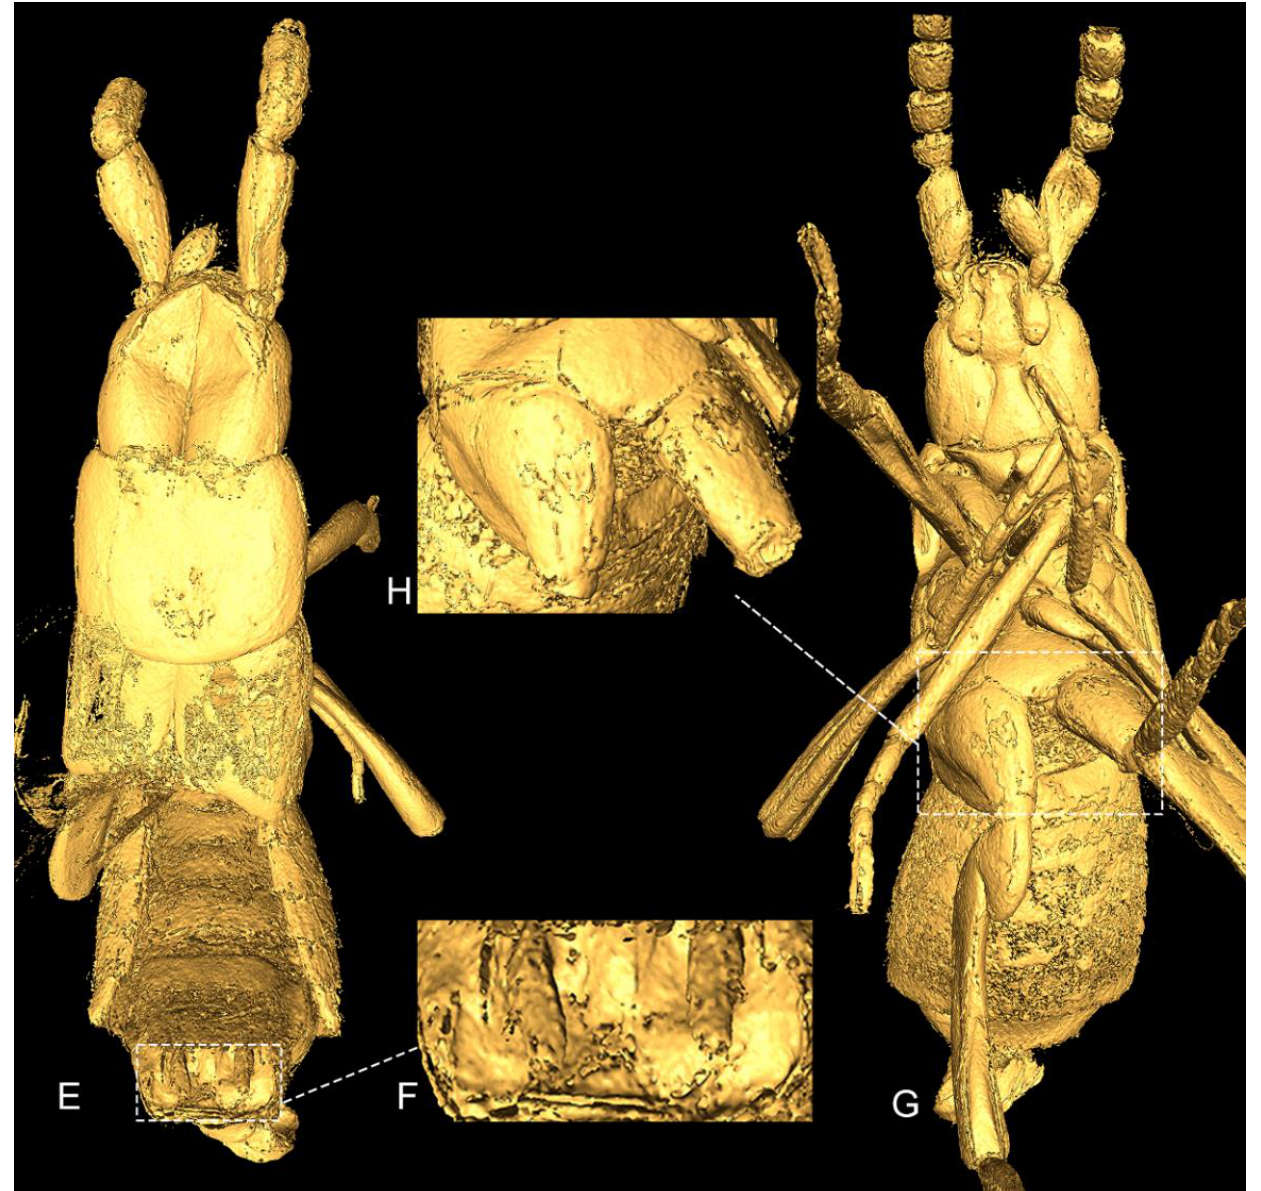
Figure 2. Pareburniola dominicana gen. et sp. nov. Head, dorsal ( A ); details of glandular region ( B ); ventral ( C ); prementum ( D ); habitus, dorsal ( E ); segment IX ( F ); ventral ( G ); metasternum ( H ).